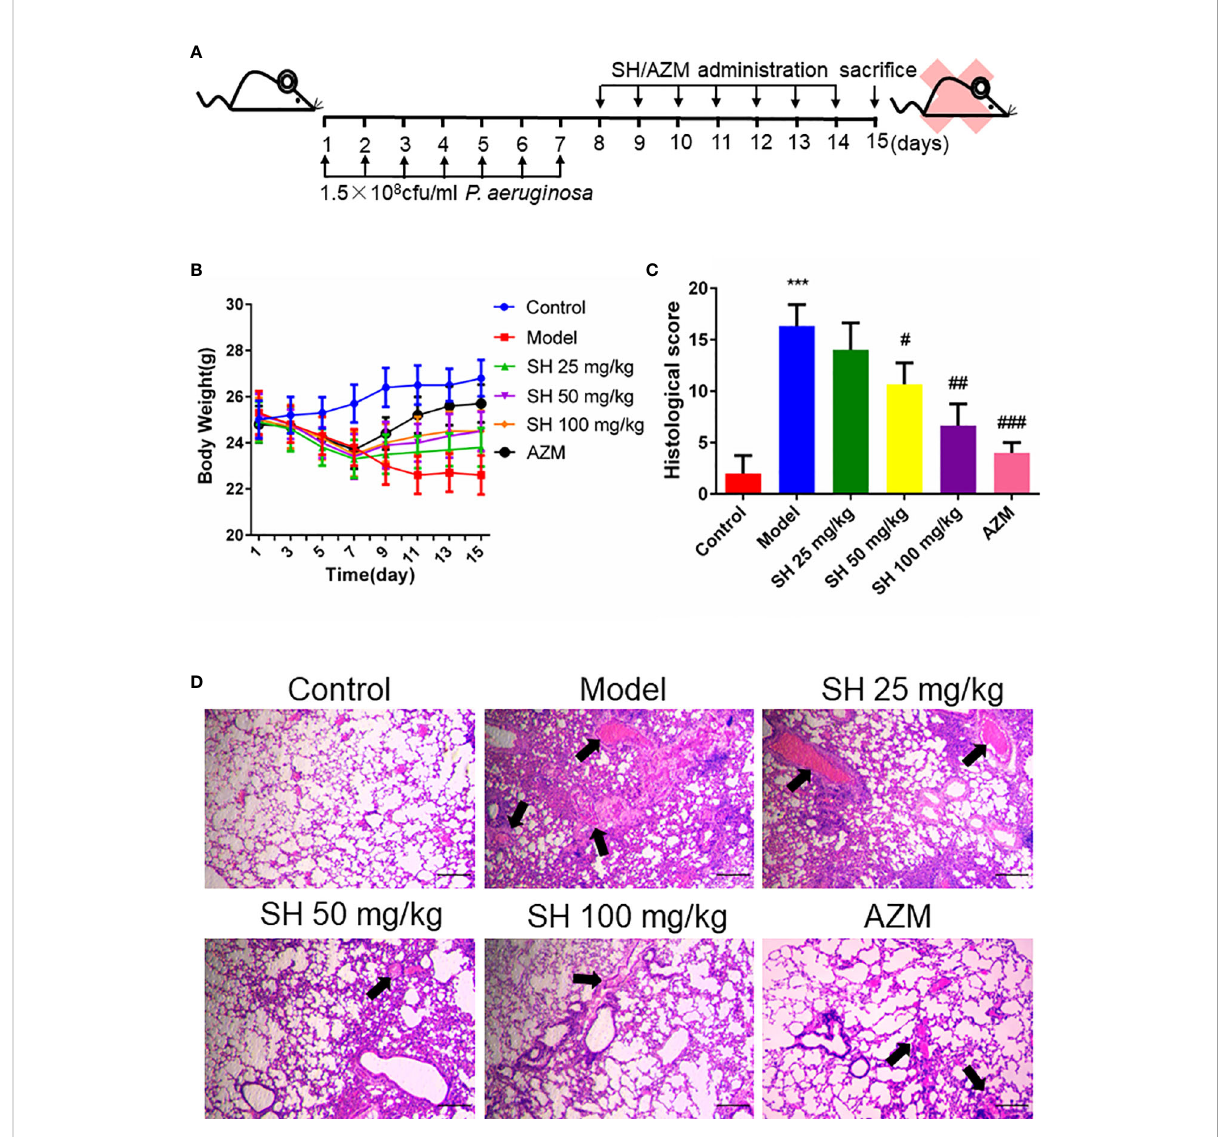
FIGURE 1 SH ameliorates histopathological changes in the lungs of mice induced by P. aeruginosa . (A) Experimental design of P. aeruginosa administration in pneumonia mice and SH treatment. (B) comparison of body weight of different treatment groups. (C) Histological scores. (D) Observe the pathological changes in the lung tissues of the mice by HE staining (×40 magni fi cation). Scale bar, 20 µm. Arrows indicate reduced alveolar air space and in fi ltration of in fl ammatory cells. Data are represented as mean ± SD (n=3). ***P<0.001 mean signi fi cance of model group compared with control group. # P<0.05, ## P<0.01 and ### P<0.001 mean signi fi cance of drug treatments compared with the model